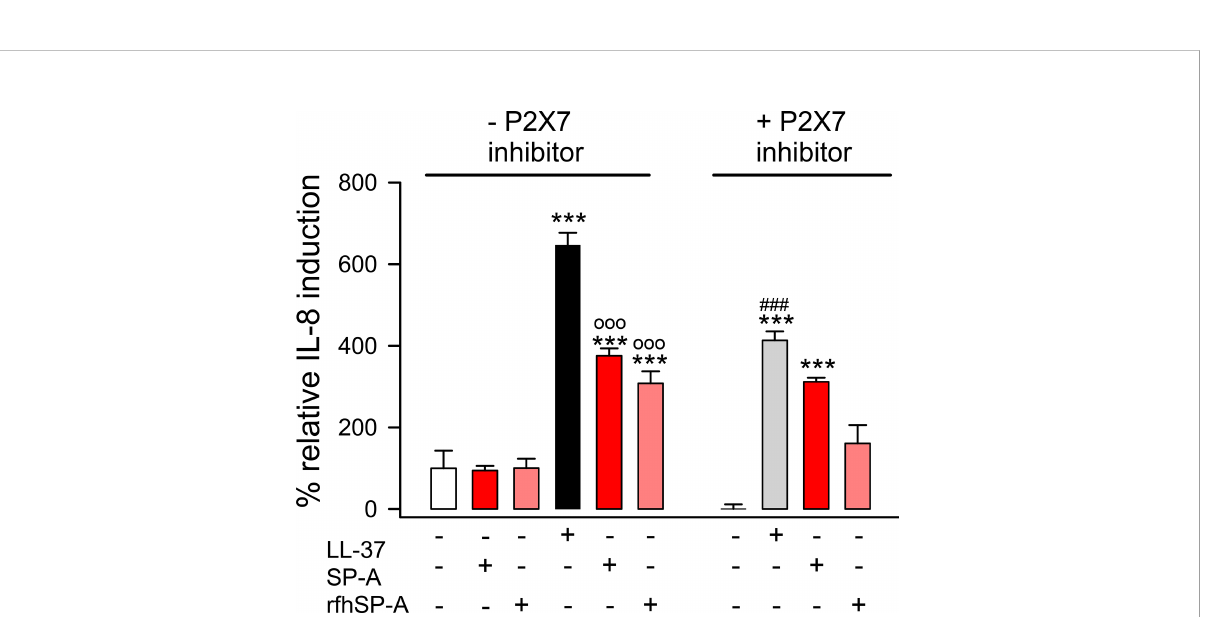
FIGURE 12 SP-A and rfhSP-A signi fi cantly reduce LL-37-induced secretion of IL-8 by alveolar epithelial cells. IL-8 release by human alveolar epithelial A549 cells was determined by ELISA from supernatants of cells pre-treated with and without an inhibitor of the purinergic receptor P2X7 (A-438079) or its vehicle (DMSO) for 15 min at 37°C. Then, cells were exposed to LL-37 (15 m M) in the presence and absence of SP-A (0.15 m M) or rfhSP-A (0.82 m M) for 24h at 37°C. Results are means ± S.E.M. of two different cell cultures with three biological replicates. For statistical analysis, ANOVA followed by Bonferroni multiple comparison test was used. ***p < 0.001 when LL-37-treated samples are compared with their respective untreated controls. ooo p < 0.001 when cells treated with SP-A/LL-37 or rfhSP-A/LL-37 complexes are compared with cells treated with LL-37. ### p < 0.01 when the effect of the P2X7 inhibitor is compared with the same sample without